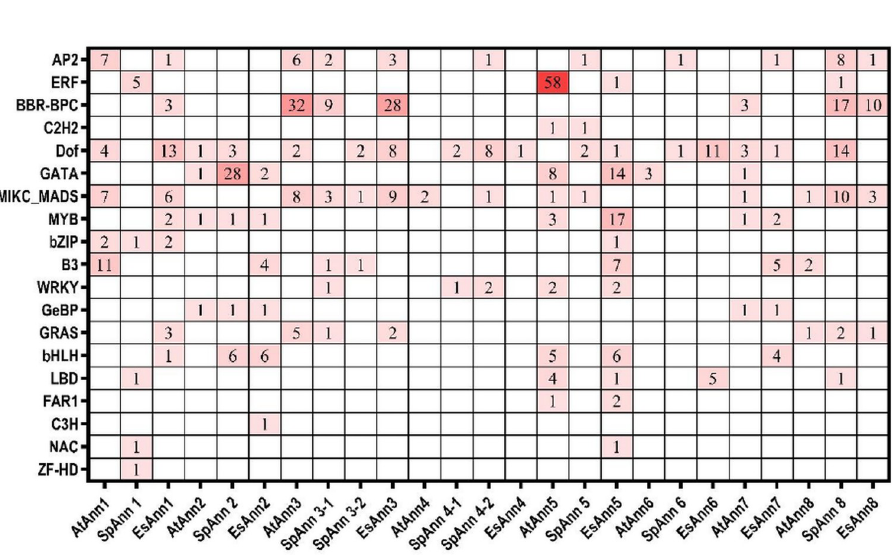
Fig 6. The analysis of TF binding sites in Ann gene family promoters in A . thaliana , E . salsugineum and S . parvula